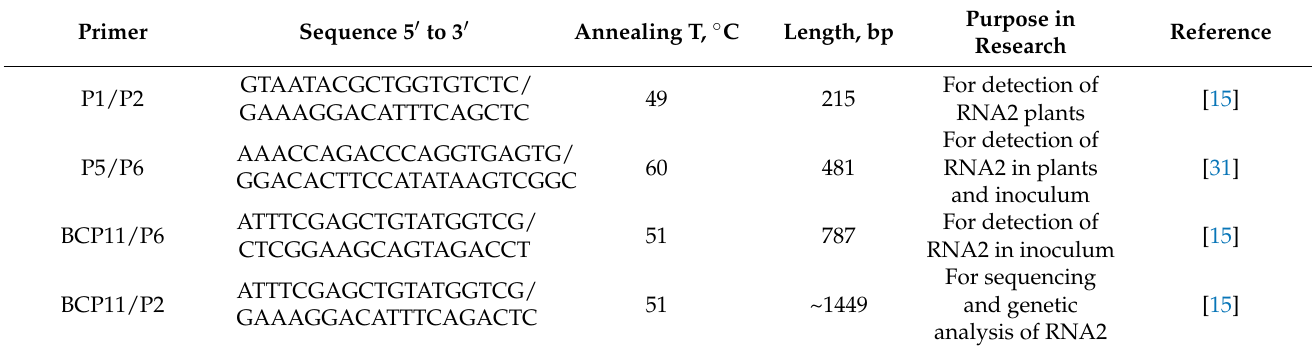
Table 2. Primer pairs used for BRV detection and